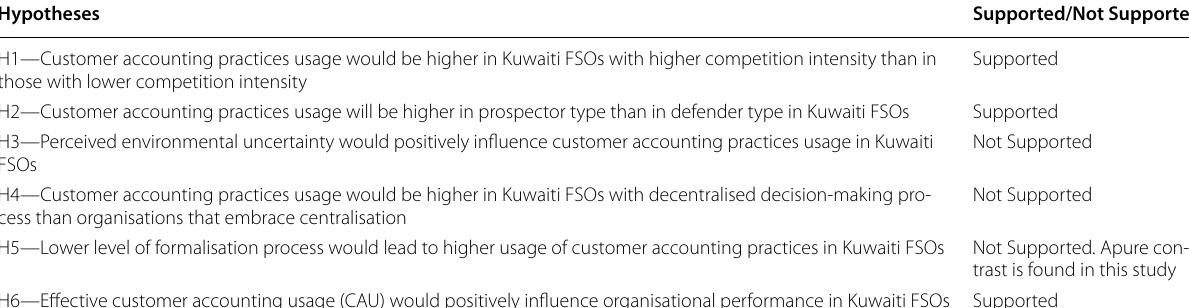
Table 9 A Summary of Findings for the